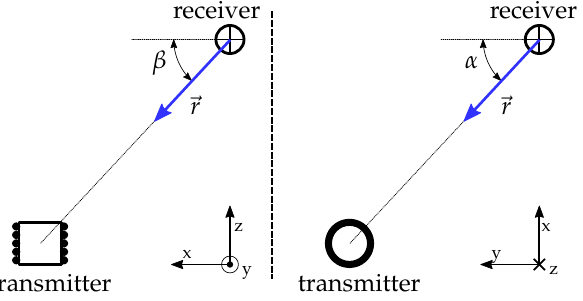
Figure 8. General transmitter–receiver arrangement and the directional vector (cid:126) r